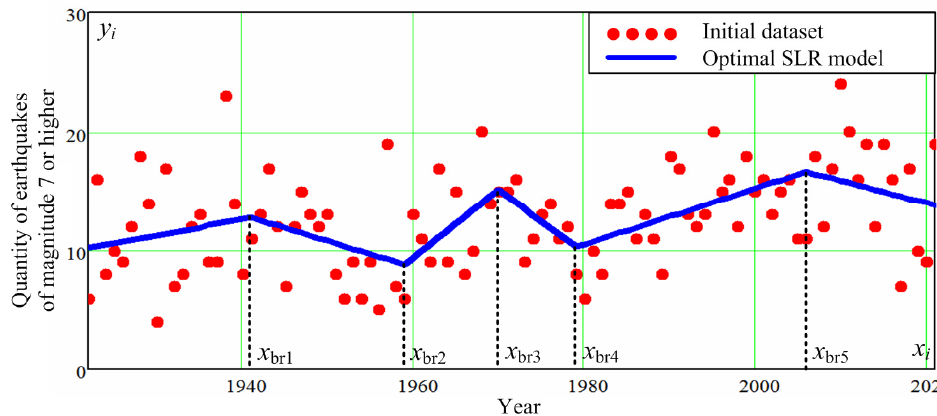
Figure 8. Observed dataset and final optimal SLR model.